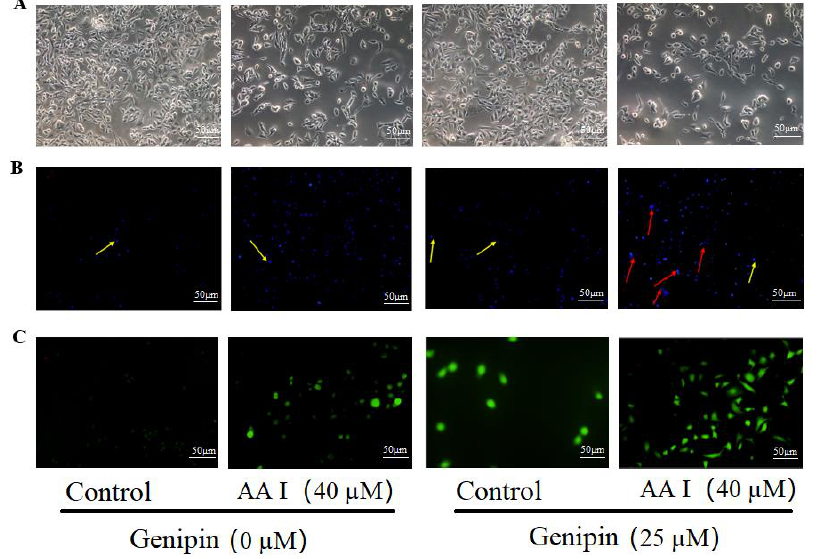
Figure 2. The toxicity of AA I to HK-2 cells was due to cell apoptosis and oxidative stress. ( A ) Inverted phase contrast microscope was used to observe cellular morphology (scale bar, 50 µ M). ( B ) The nuclear morphology of HK-2 cells was evaluated using Hoechst 33,258 staining by a fluorescence microscope (scale bar, 50 µ M). The yellow arrows indicate the chromatin condensation, which is brightly stained and the red arrows show DNA fragmentation. ( C ) The intracellular ROS was measured using fluorescence microscopy (scale bar, 50 µ M) with probe DCFH-DA. HK-2 cells were treated with 40 µ M AA I or 25 µ M genipin for 24 h.